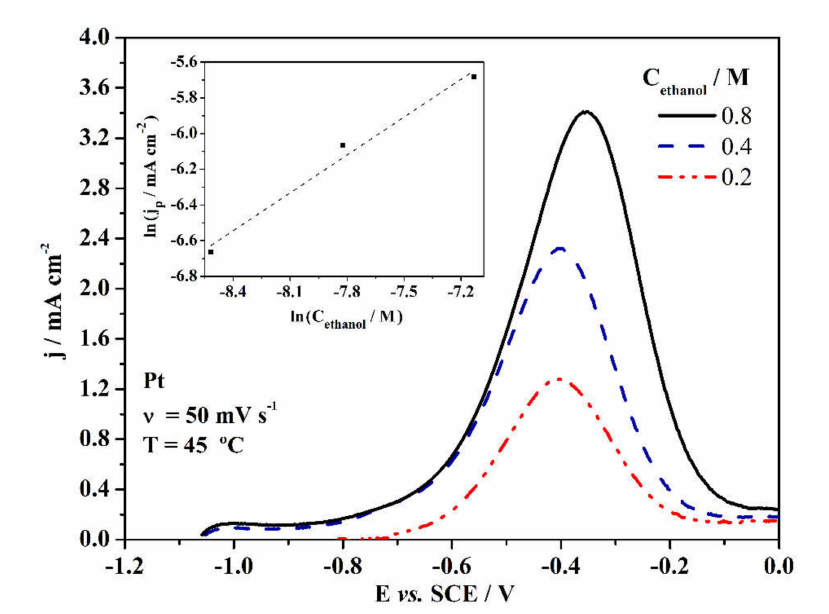
Figure 7. E ff ect of ethanol concentration (0.2–0.8 M) on the anodic scans of Pt electrode at 50 mV s − 1 and 45 ◦ C. Inset shows the corresponding ln j p vs. ln C plot used for determining the reaction